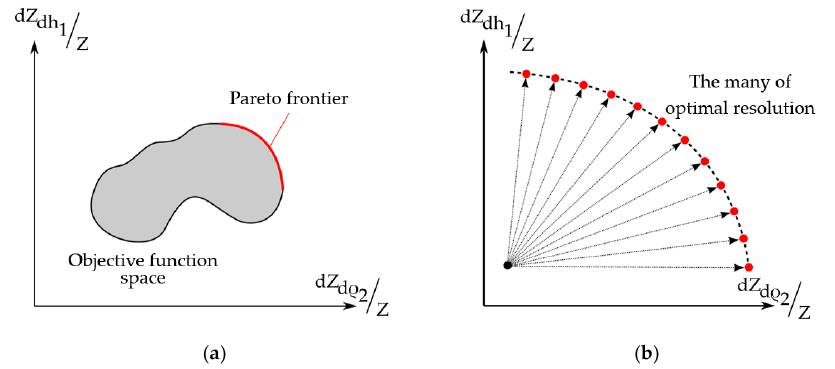
Figure 12. ( a ) Pareto frontier; ( b ) global multiobjective problem statement.